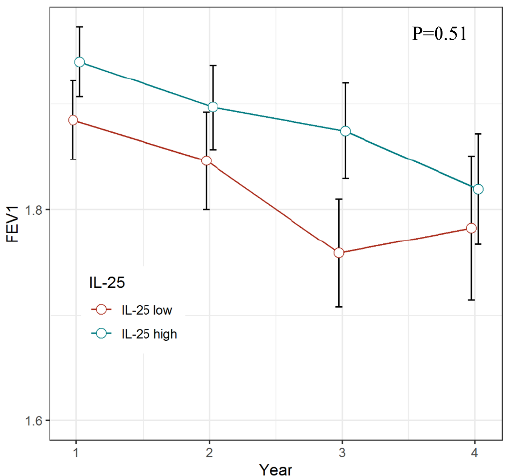
Figure 1. Differences in lung function trajectory between IL-25-low and IL-25-high groups.